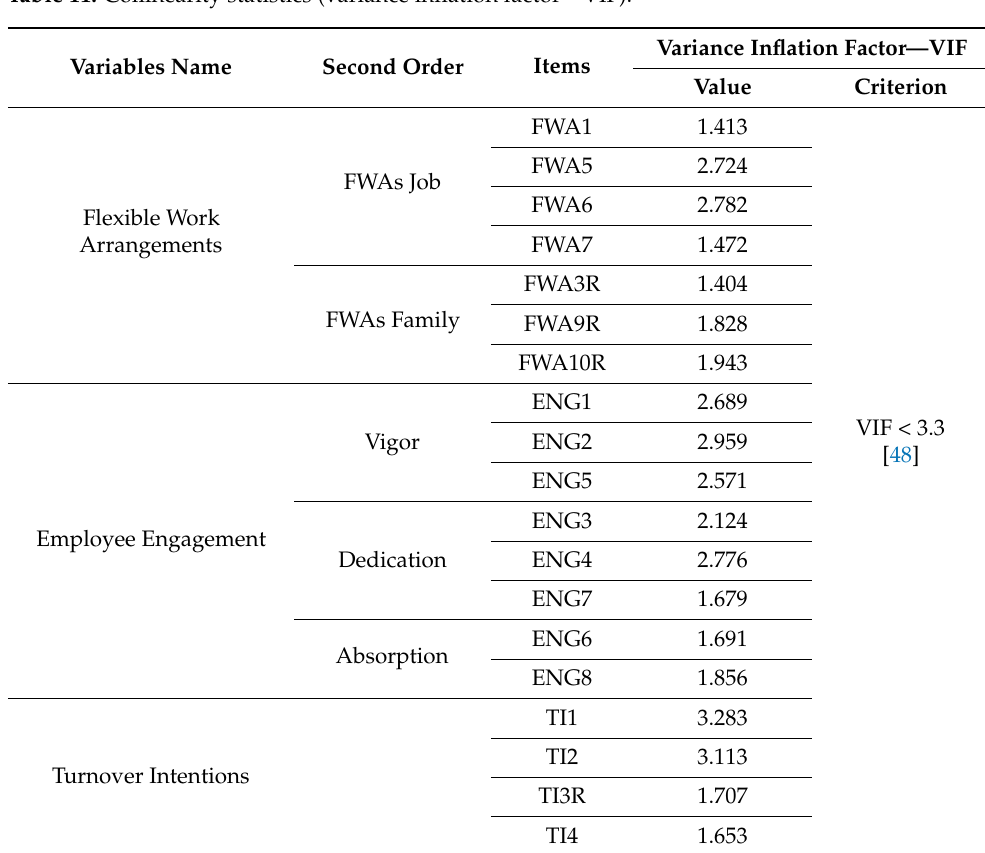
Table 11. Collinearity statistics (variance inflation